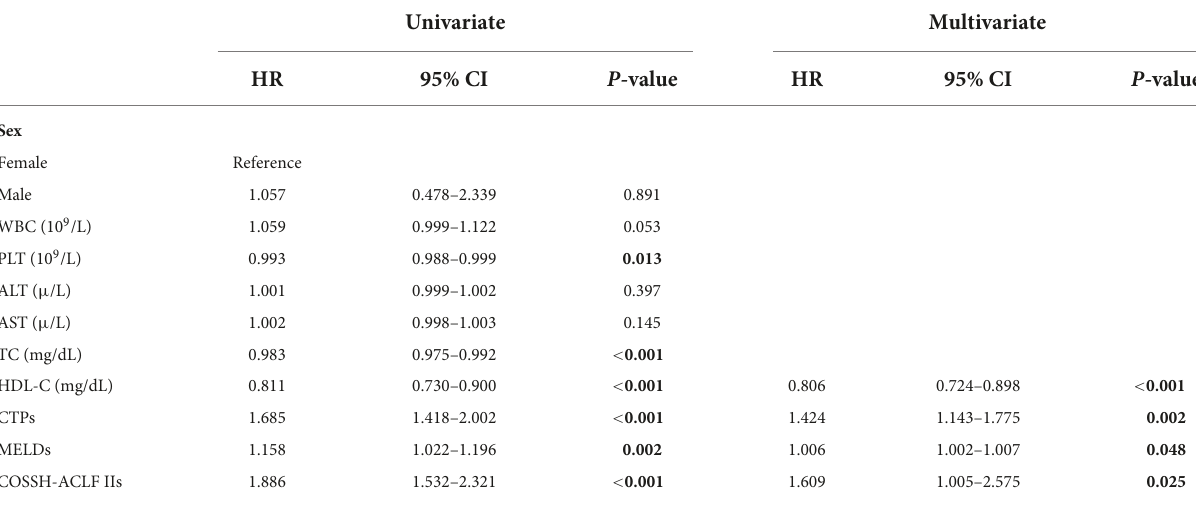
TABLE 2 Univariate and multivariate analyses of risk factors associated with mortality in hepatitis B virus-related acute-on-chronic liver failure (HBV-ACLF) patients. Univariate